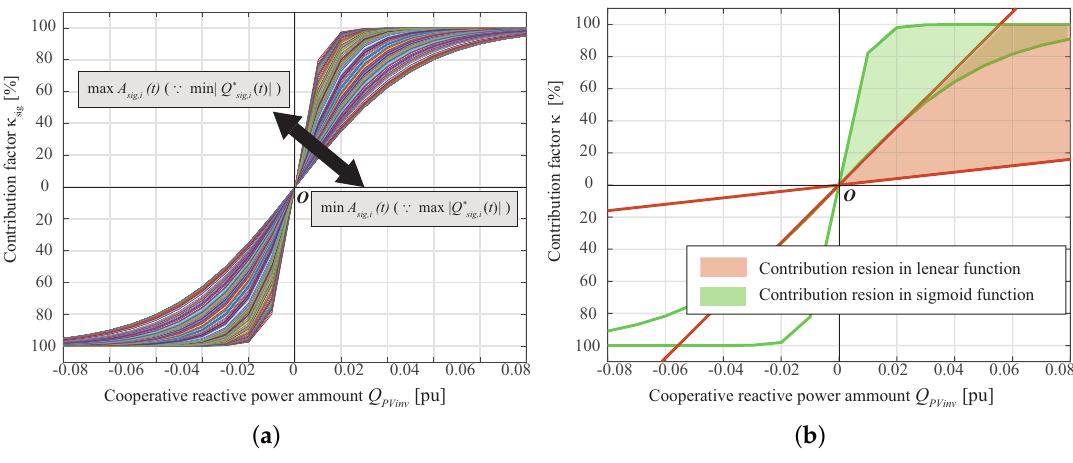
Figure 5. Sigmoid contribution factor of reactive power incentive. ( a ) Sigmoid contribution function for hourly powerand each node and ( b ) contribution region of the sigmoid and linear